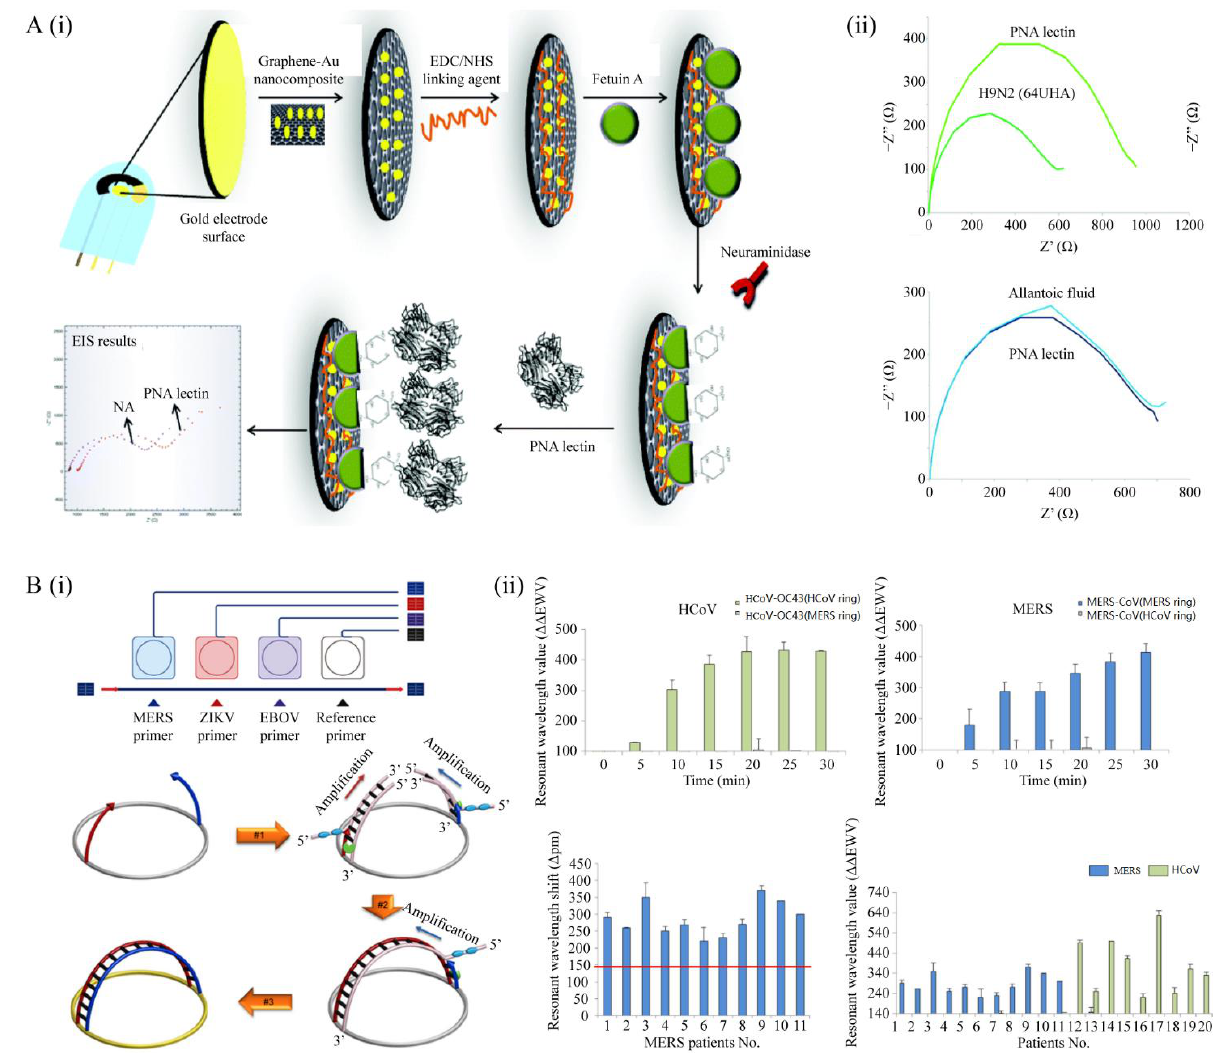
Figure 3. Biosensors for respiratory virus detection. ( A ) ( i ) Schematic of development of electrochemical influenza A biosensor; ( ii ) selectivity of the biosensor (reproduced with [51]. Copyright 2017, Royal Society of Chemistry). ( B ) ( i ) Scheme of the arch-shaped multiple-target sensing platform for diagnosis and identification of emerging infectious pathogens; ( ii ) utility of the arch-shaped multiple-target sensing platform in detecting of clinical samples (reproduced with [54]. Copyright 2018, Royal Society of Chemistry).